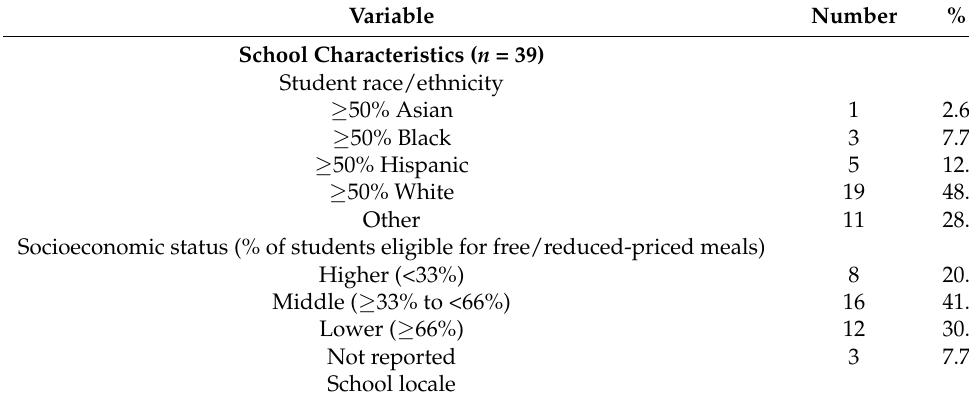
Table 1. Characteristics of public elementary schools and interview